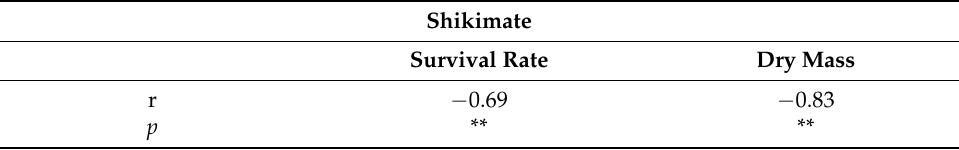
Figure 3. Shikimate accumulation in susceptible NW (S) and putative resistant R2 (R) plantago ( Plantago lanceolata L.) after application at various glyphosate dosages rates. Means indicated by different letters differed significantly at p ≤ 0.05 according to Fishers LSD. Means are pooled from two experiments. Vertical bars denote ± standard error of the mean.